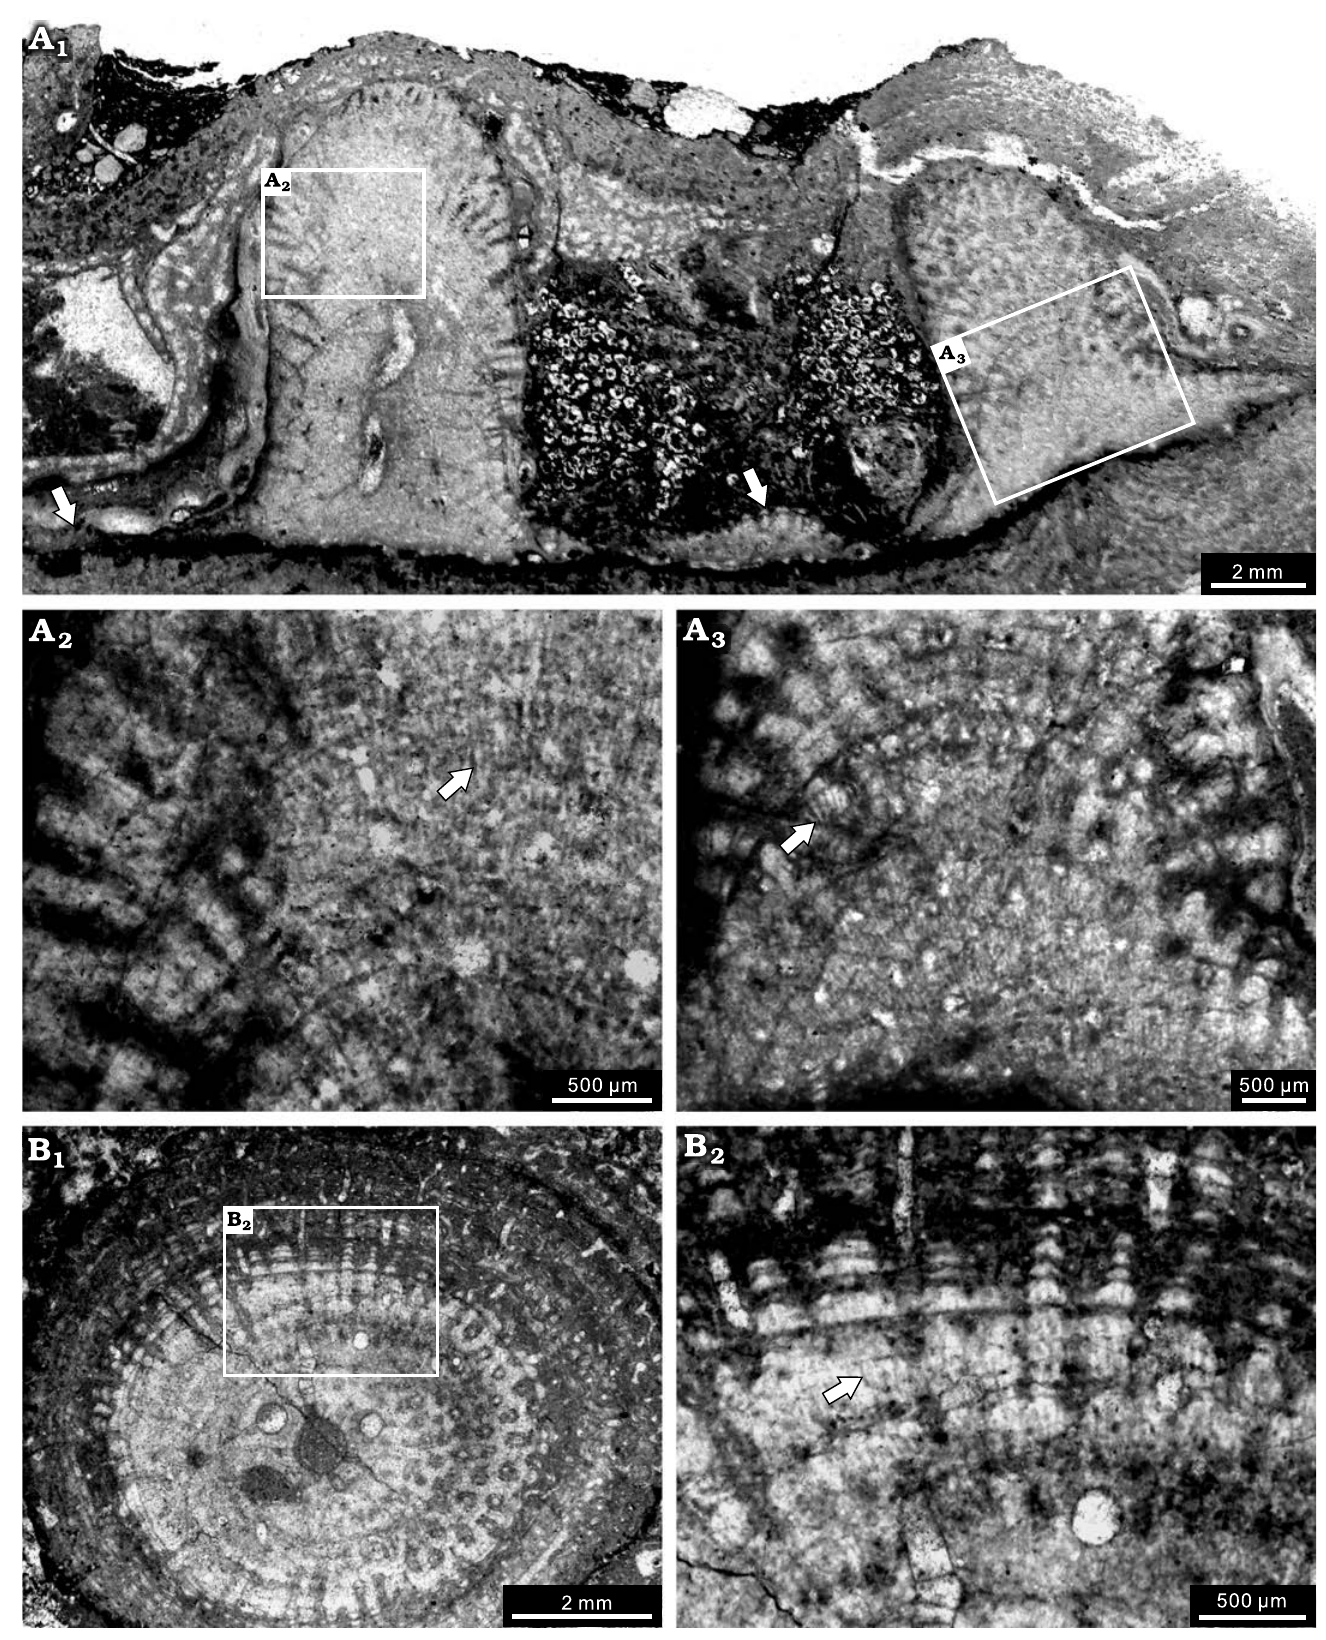
laminar skeleton in the bottom (arrows); A 2 , enlargement of A 1 , note the striated microstructure (arrow); A 3 , enlargement of A 1 , showing autotubes and striated microstructure (arrow). B . NIGP 177059; B 1 , tangential section showing the regular autotubes; B 2 , enlargement of B 1 , note the striated microstructure